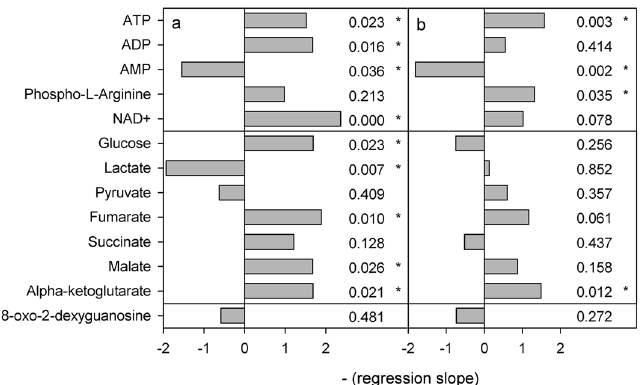
Figure 1. Results of linear regressions on transformed metabolite concentrations in C. glacialis copepodites as a function of pH (range 8.0–7.0 pH T ). ( a ) Copepodite stage CIV, ( b ) copepodite stage CV. The horizontal grey bars show negative regression slopes to indicate the direction of change with decreasing pH and the numbers show the p-values of the slopes, asterisks mark significant slopes. Upper panels show molecules carrying energy or redox potential, middle panels show metabolites involved in glycolysis or TCA cycle and lower panel show a product of oxidative